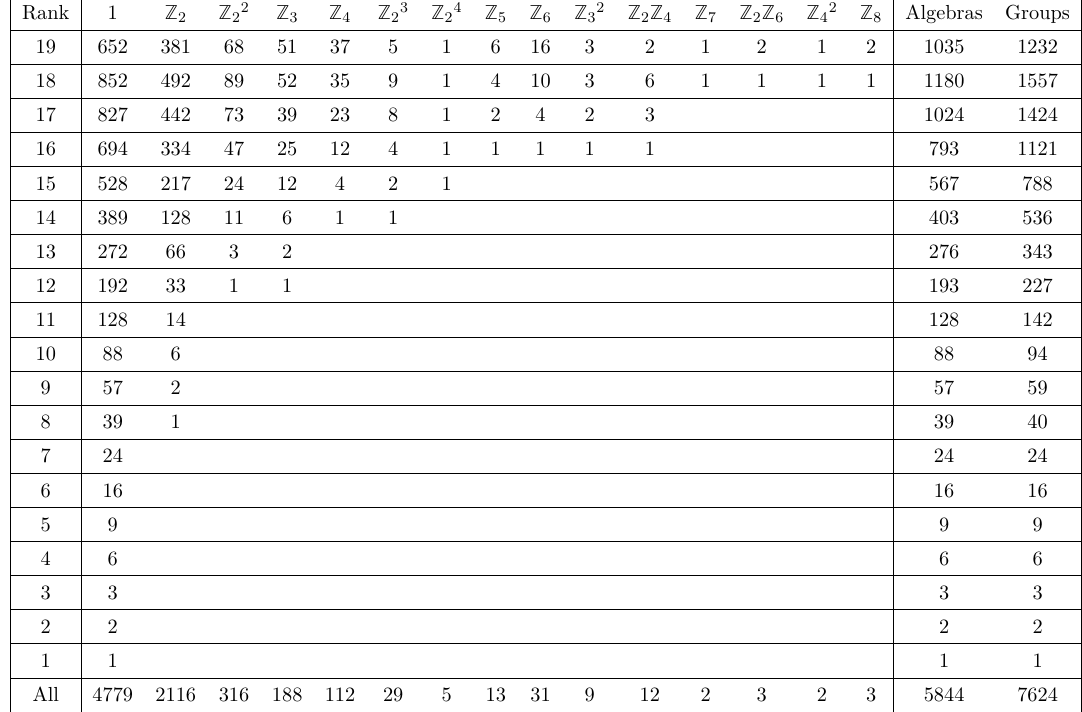
Table 2 . Number of algebras and groups of each rank with a certain fundamental group for the heterotic string on T 3